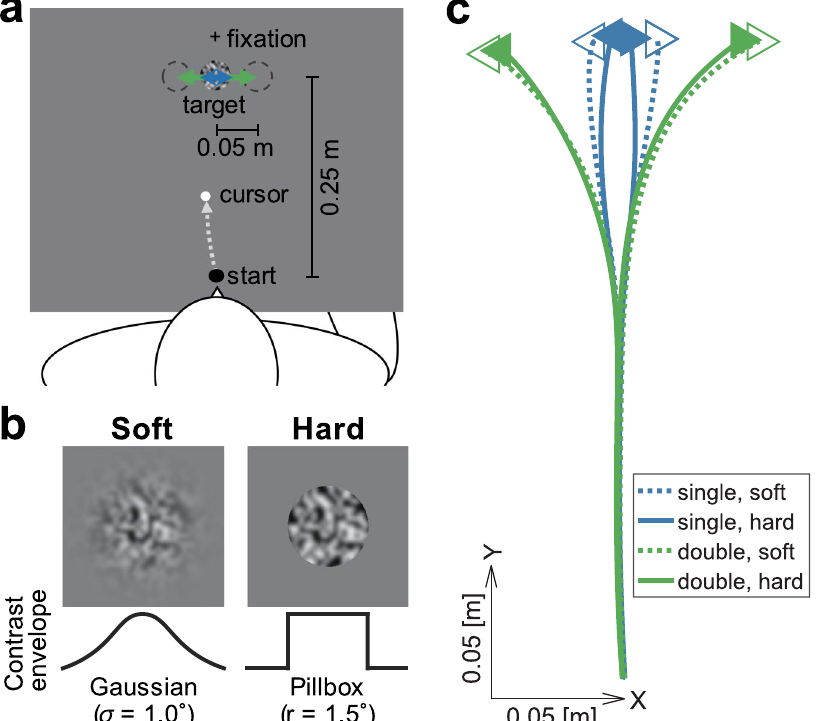
Figure 1. Experimental setup, stimuli, and hand trajectories. ( a ) Configuration of the experimental setup. Participants performed a reaching task while holding the handle of a manipulandum from the start position to the target position. In randomly selected trials, immediately after the reaching onset, the internal texture of the target stimulus started to move in the horizontal direction with or without the edge position drifting (single- and double-drift conditions, respectively). Participants quickly made an online adjustment when the target position shifted. ( b ) Target stimuli. The soft- and hard-edge targets were created by applying the contrast envelope of a Gaussian function and a pillbox function, respectively, to a Gaussian smoothed random dot pattern. ( c ) Mean trajectories for single-drift (blue) and double-drift (green) conditions of a particular participant. The dotted curves and open triangles represent the trajectories and arrival positions for the soft- edge target, and the solid curves and filled triangles represent those of the hard-edge target. The direction of the triangle indicates the direction of the texture